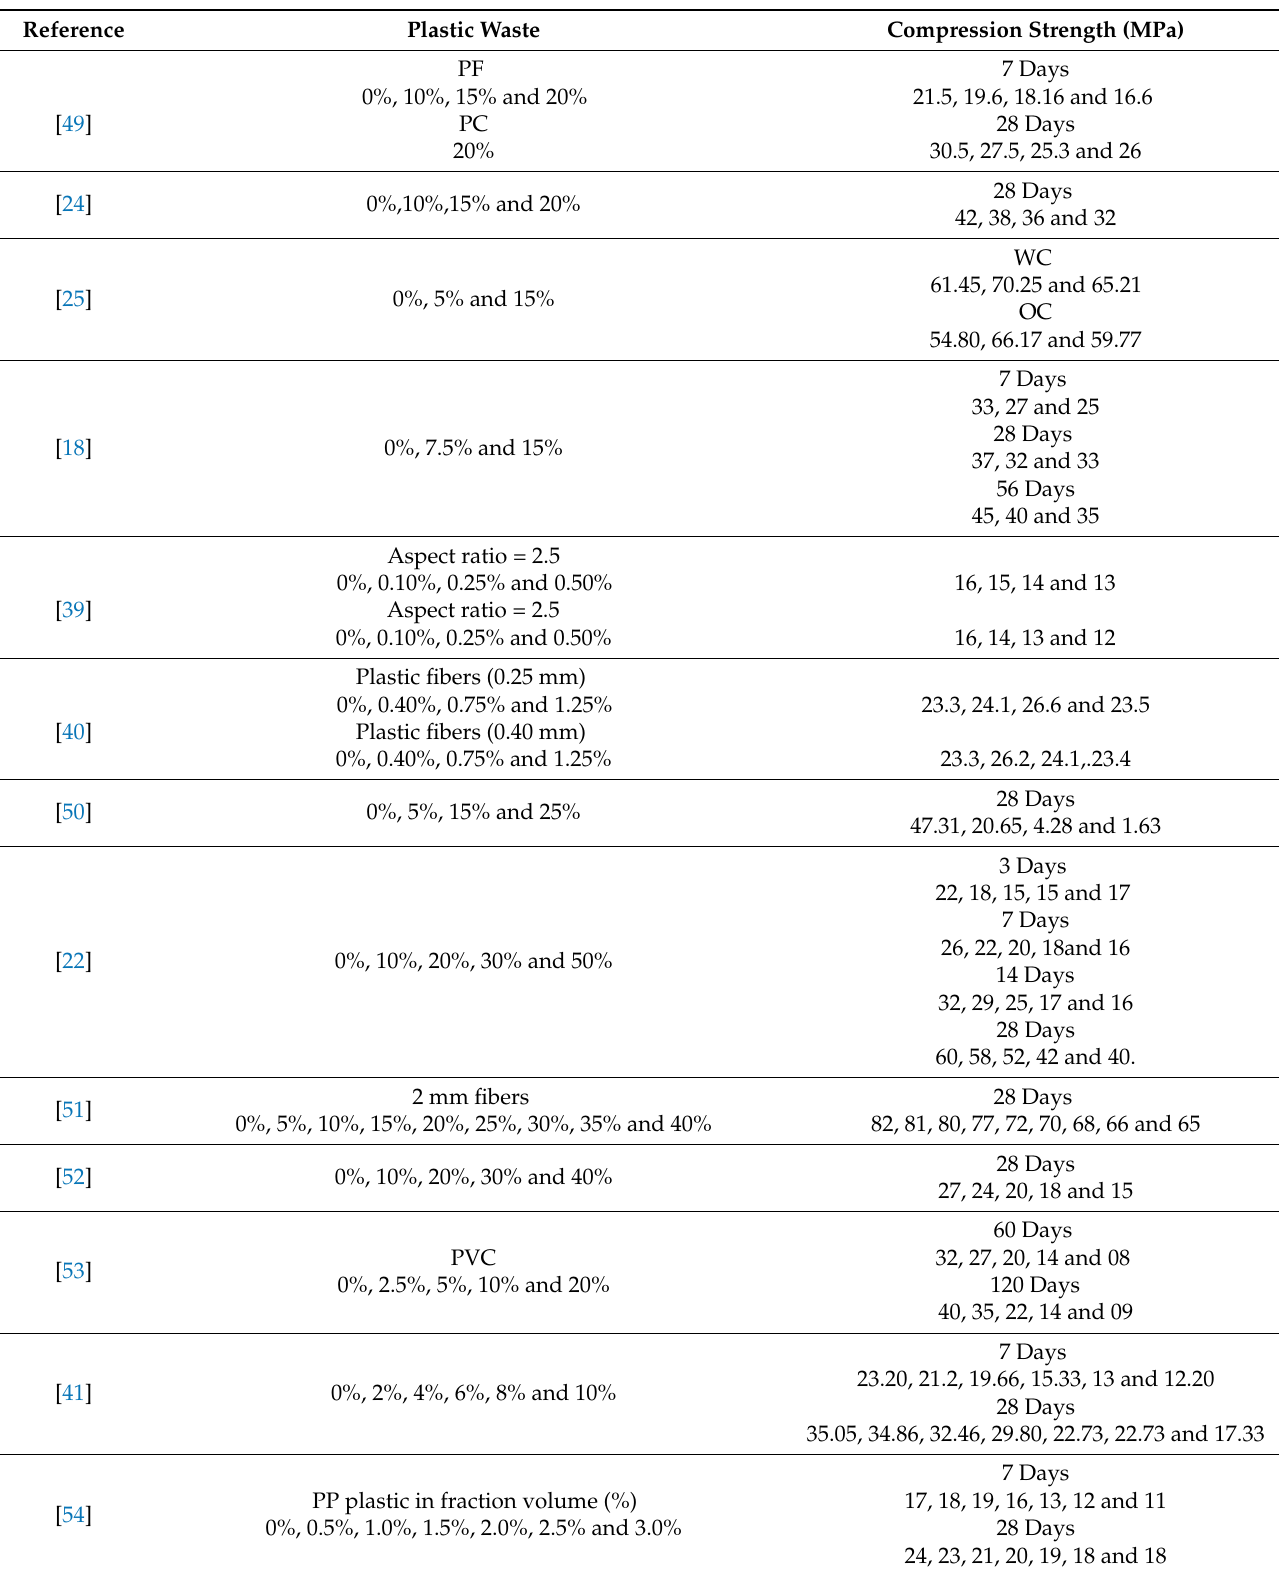
Table 3. Summary of Compressive Strength